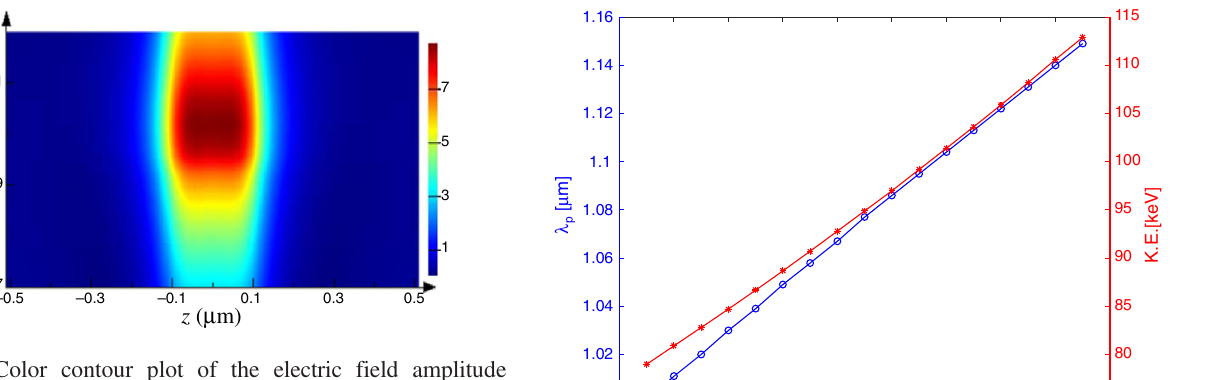
FIG. 2. Color contour plot of the electric field amplitude normalized to that of the driving field as a function of the wavelength and longitudinal position within a single unit cell.